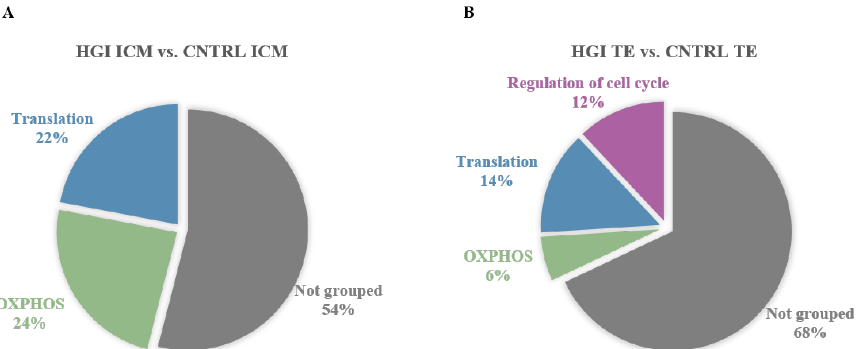
Figure 9. Significantly enriched gene sets (FDR < 0.05) in the ICM and TE transcriptomes of in vitro- developed blastocysts with HGI compared to CNTRL. Significantly enriched gene sets were identified by GSEA with the Molecular Signature Database (MSigDB) gene set collections: Hallmarks, KEGG, Reactome, and GO BP. GSEA was followed by SUMER analysis for gene set condensation. ( A ). Pie charts showing the enriched gene sets in HGI ICM versus CNTRL ICM. ( B ). Pie charts showing the enriched gene sets in HGI TE versus CNTRL TE. ICM, inner cell mass. TE, trophectoderm.